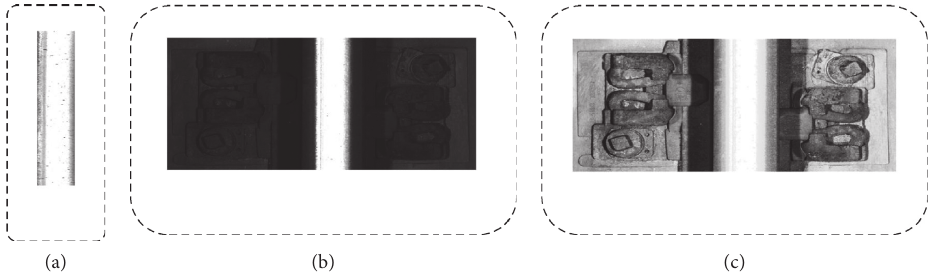
Figure 6: Template images. (a) The rail template. (b) The symmetrical fastener template. (c) The fastener template after image preprocessing. 1 e 10